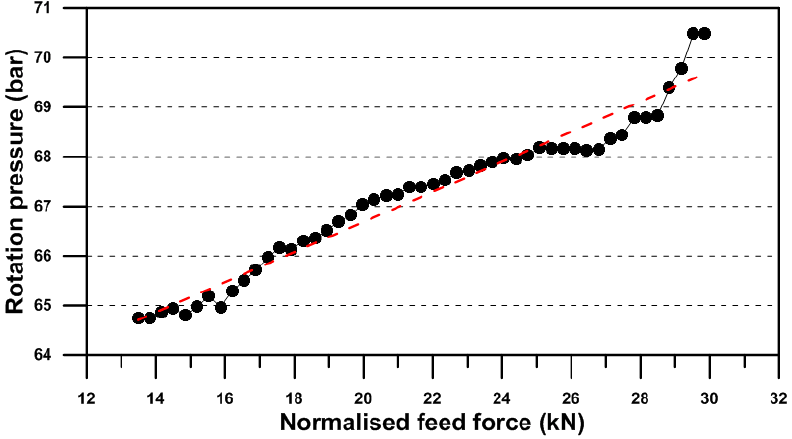
Figure 12. Rotation pressure versus normalised feed force.